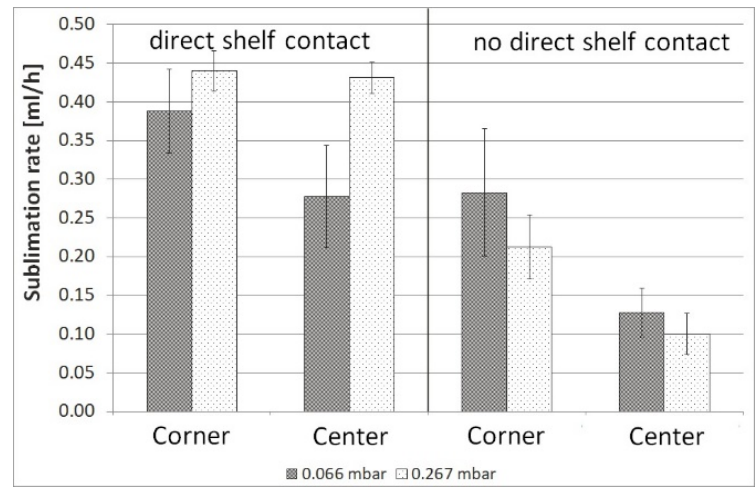
Figure 9. Mean sublimation rates in center and edge vials, either with direct contact to the shelf or without, at 0.066 mbar, error bars represent standard deviation ( n = 10).